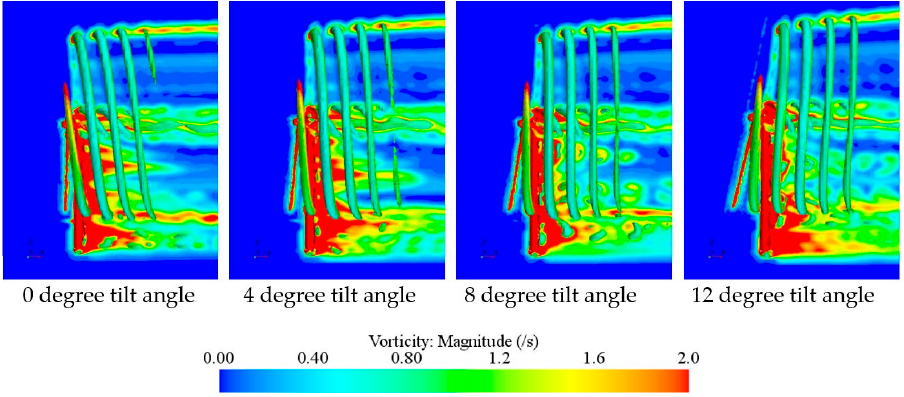
ff erent nacelle tilt